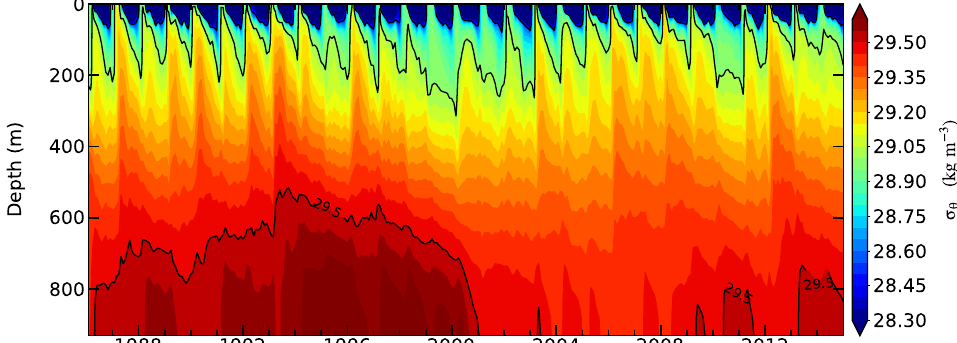
Figure 16. Hovmöller diagram of simulated potential density with depth for the 30-year period, at Skyros basin, central-north Aegean Sea ( ∼ 39 ◦ N, 25 ◦ E). Color-scale contours have a spacing of 0.05 kg m − 3 , while black contours are shown every 0.5 kg m − 3